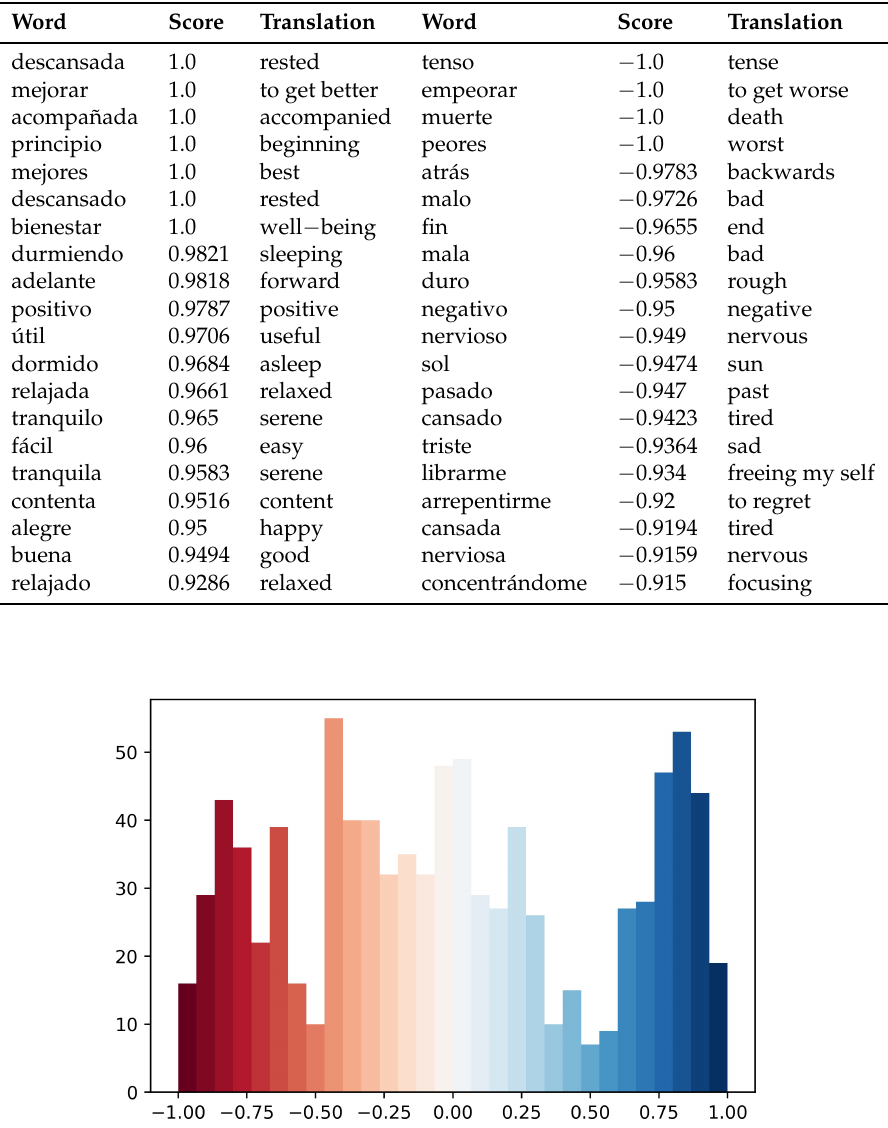
Table 2. Top 20 most positive and most negative words, respectively.